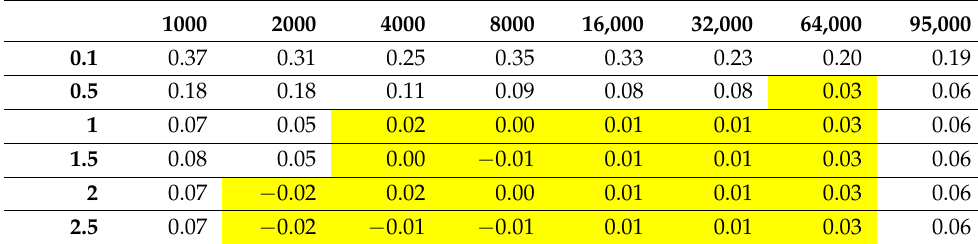
Figure 9. Convergence analysis for the models simplified using retopology with the adaptive size fixed at 30. Highlighted in yellow are the results on convergence expressed in percentage in relation to the result given by the analysis and the analytical result calculated for the specimen. Expressed in a graph. Table 8. Convergence analysis for the models simplified with retopology and the adaptive size parameter fixed at 100. In yellow, the results gone to convergence are expressed in percentage in relation to the result given by the analysis and the analytical result calculated for the specimen.